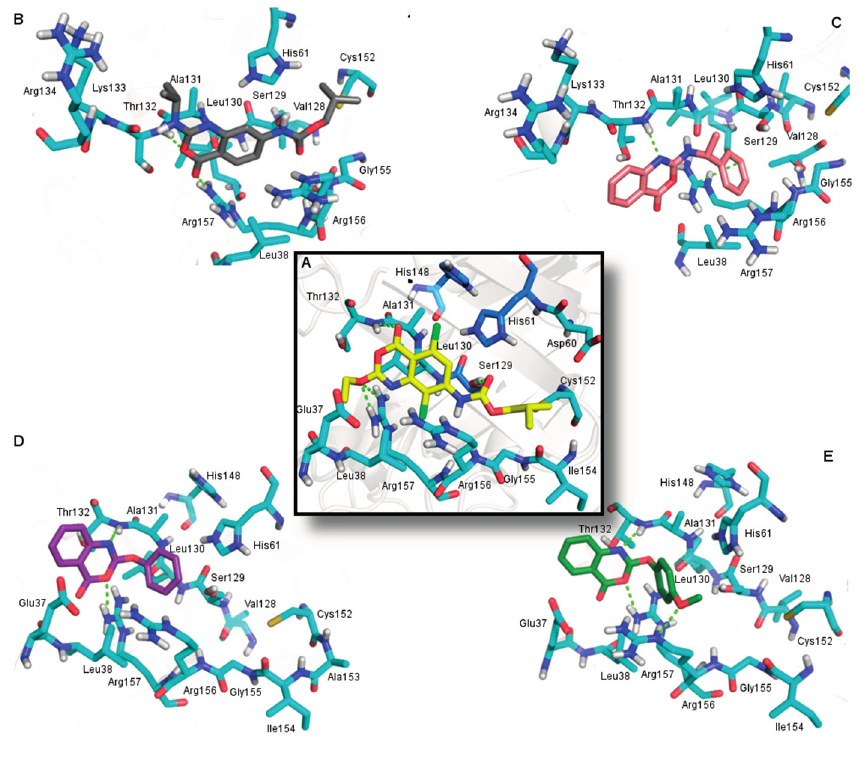
Figure 4. Molecular docking results between HSV-1 protease (blue) and: ( A ) benzoxazinone 15 (yellow); ( B ) benzoxazinone 6 (gray); ( C ) benzoxazinone 8 (pink); ( D ) benzoxazinone 17 (purple) and ( E ) benzoxazinone 18 (green). Hydrogen bonds and cation- π interactions are indicated in